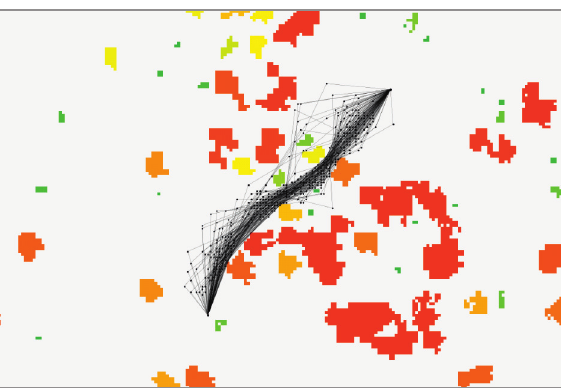
Figure 7: Ship route optimization by proposed near-field route optimization